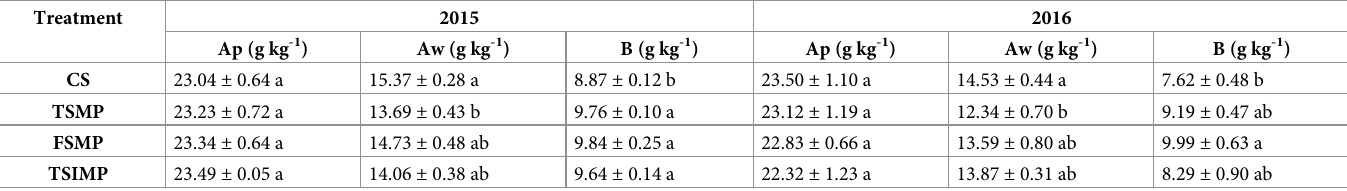
Table 4. Effects of soil mixing on the organic carbon of Albic soil.